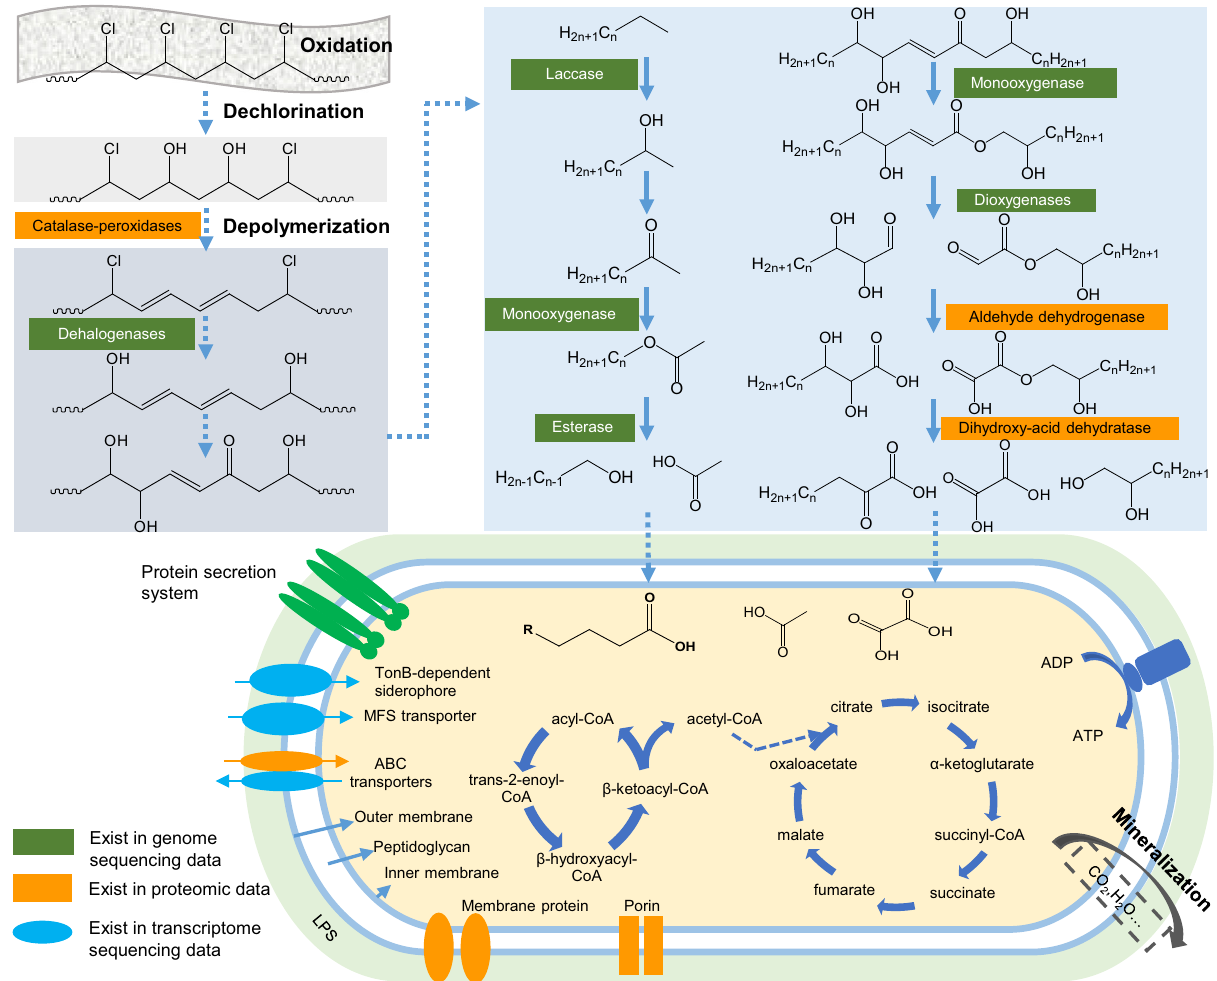
Fig. 5 | Putative PVC degradation pathway of strain EMBL-1. The pathway was proposed based on multiomic analyses that integrated the genomic, proteomic, transcriptomic, and metabolomic results for strain EMBL-1 during growth on PVC fi lm. Solid arrows in the fi gure represented one-step reactions, and dashed arrows represented multi-step reactions. The range of ‘ n ’ in the formula of right upper panelwas4~24.Theproteinsinthegreentextboxandovalwereproteinsencoded